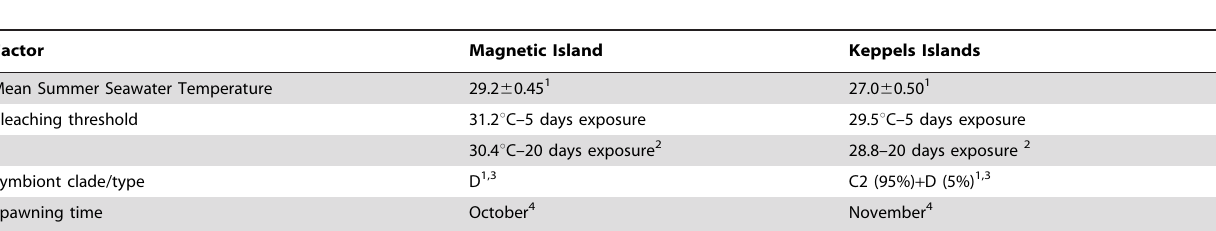
Table 2. Comparison of Magnetic Island and the Keppel Island field locations and their A. millepora populations.